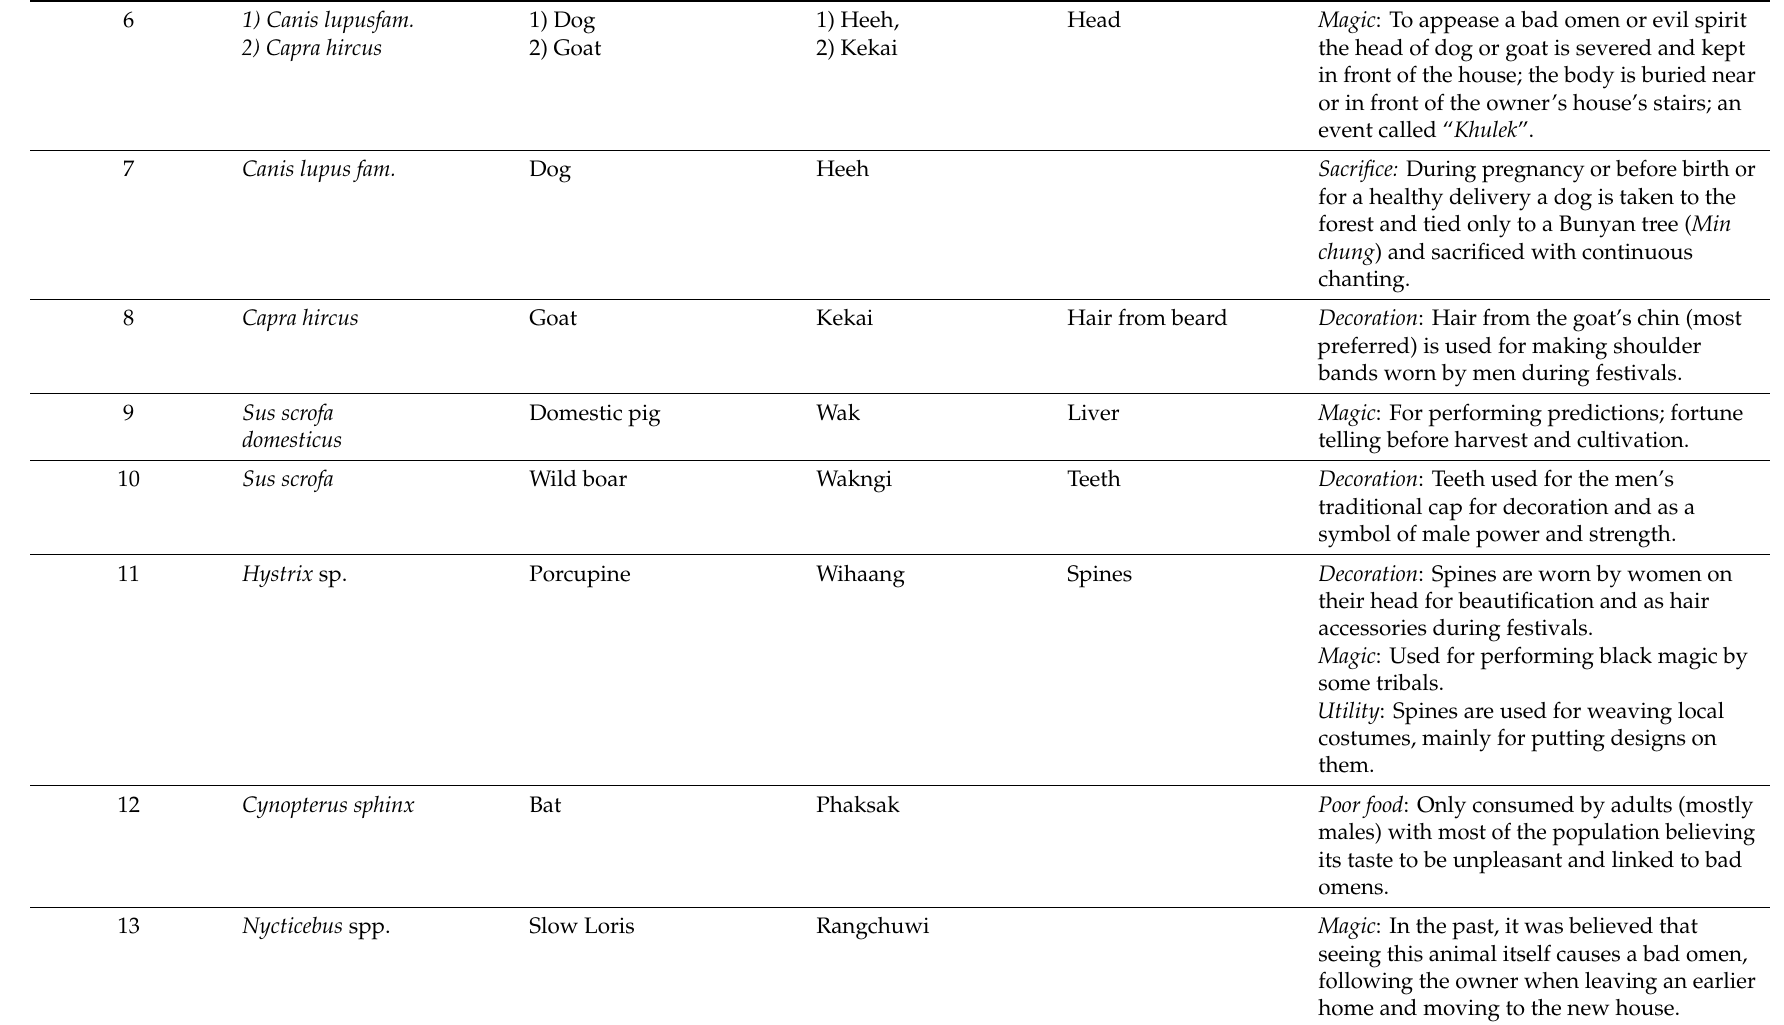
symbol of male power and strength. Decoration : Spines are worn by women on accessories during